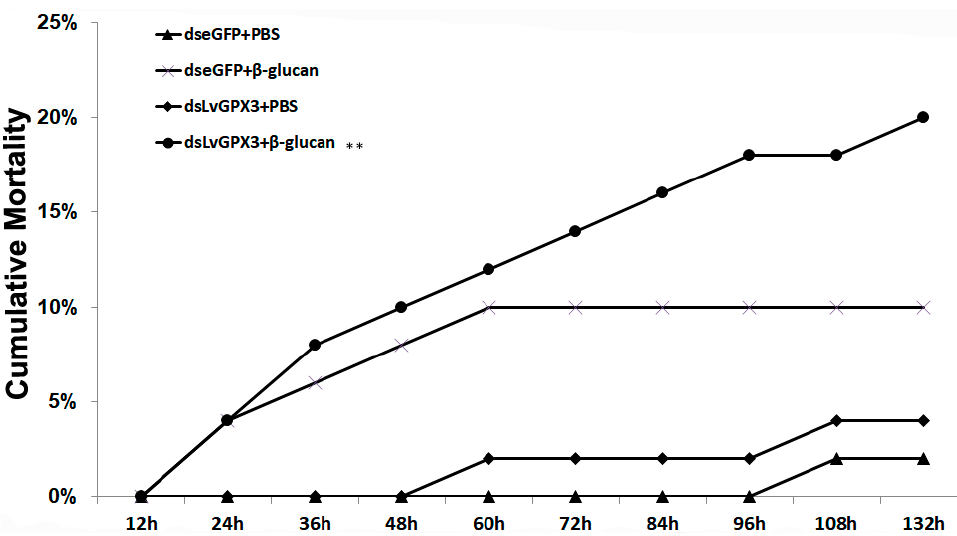
Figure 4. Knockdown of expression of LvGPX3 increased cumulative mortality of shrimps under oxidative stress. Shrimp ( n = 50) were injected intramuscularly with dseGFP (control) or dsLvGPX3. At 48 h after the initial injection, shrimps were injected with β -glucan or PBS. Cumulative mortality was recorded every 4 h. The mortality levels among different treatments were analyzed by Kaplan– Meier plot (log-rank X 2 test). Significant differences in L. vannamei mortality were marked with asterisks (** indicates p < 0.01).